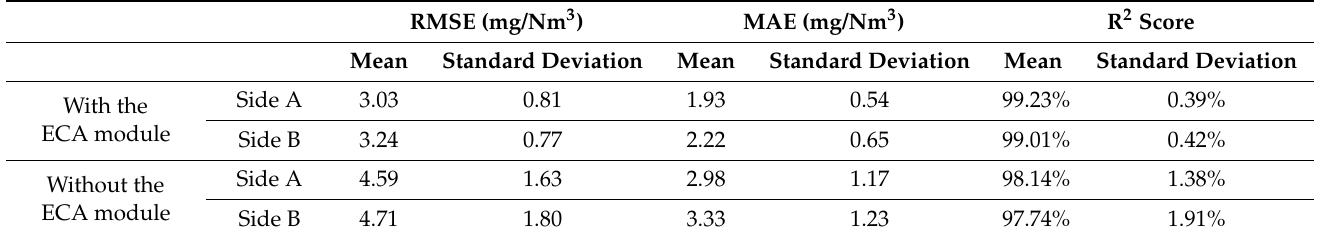
Table 3. The comparison results of our model with and without the ECA module.